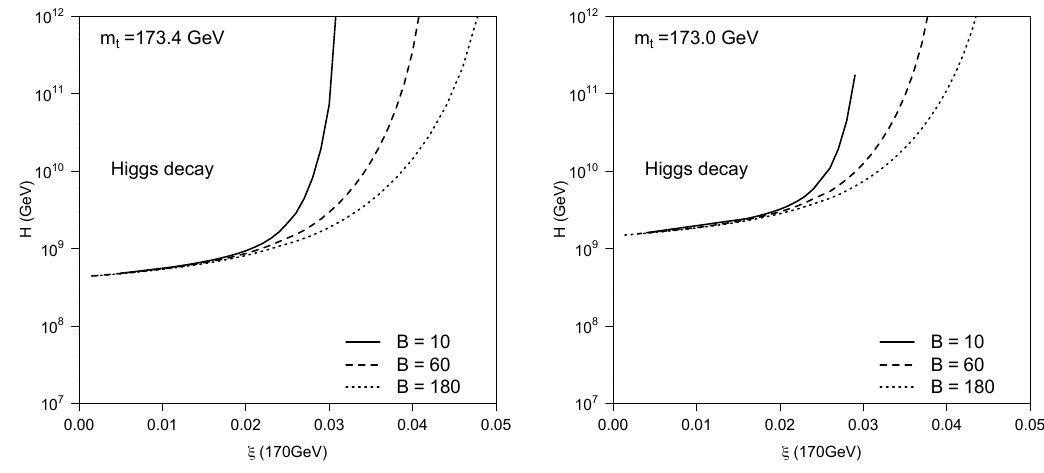
Figure 3 . Higgs instability regions plotted as a function of the in(cid:13)ationary expansion rate and the curvature coupling (cid:24) at 170GeV, assuming (cid:22) 2 = 0 at 170GeV. Lines show the exponent B , related to the vacuum decay rate per physical horizon volume, which is of order e (cid:0) B . The Higgs vacuum is unstable in the region above these